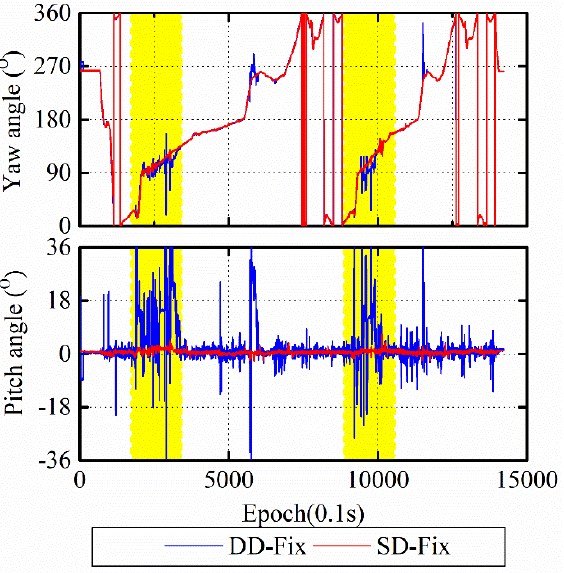
Figure 10. Comparison of yaw (top) and pitch (bottom) angle between DD-Fix and SD-Fix.